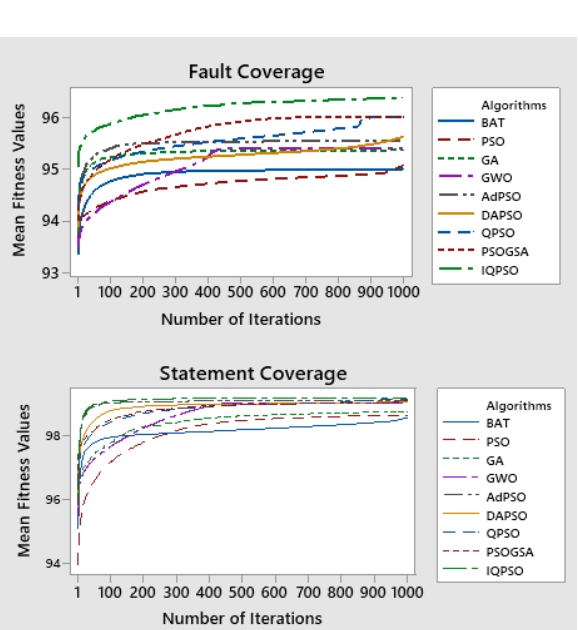
Figure 1. Convergence curves of algorithms for fault and statement coverage criteria of TCP. It was also observed that most of the algorithms had equivalent variance in the case of statement coverage. The boxplots in Figure 2 also depict variation in algorithmic performance for fault coverage that is higher for statement coverage. This is because faults are dispersed across the entire software. In other words, most test cases cover almost the same statements. Therefore, the statement coverage boxplots are more compressed than the fault coverage boxplots. Overall, the proposed IQPSO is superior to all other algorithms in terms of